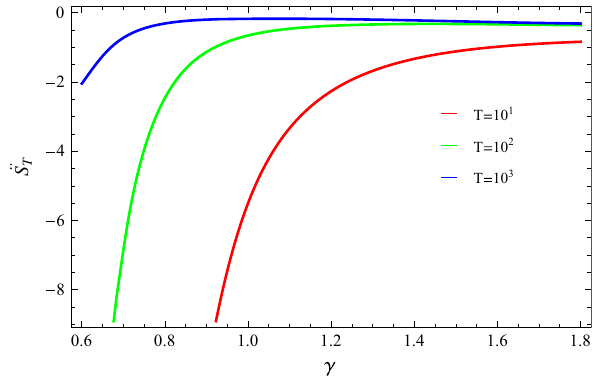
Fig. 8 Plot of ¨ S T versus γ